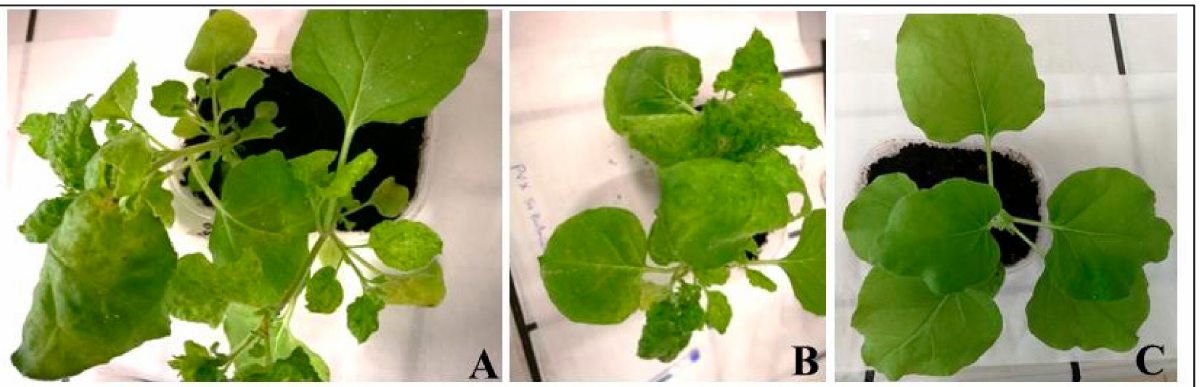
Figure 2. Symptoms developed on Nicotiana benthamiana plants mechanically inoculated with extracts from naturally infected eggplants leaves. ( A , B ): Systemic mild mosaic and irregular white lesions on small leaves and intermediate leaf rugosity; ( C ): Mock